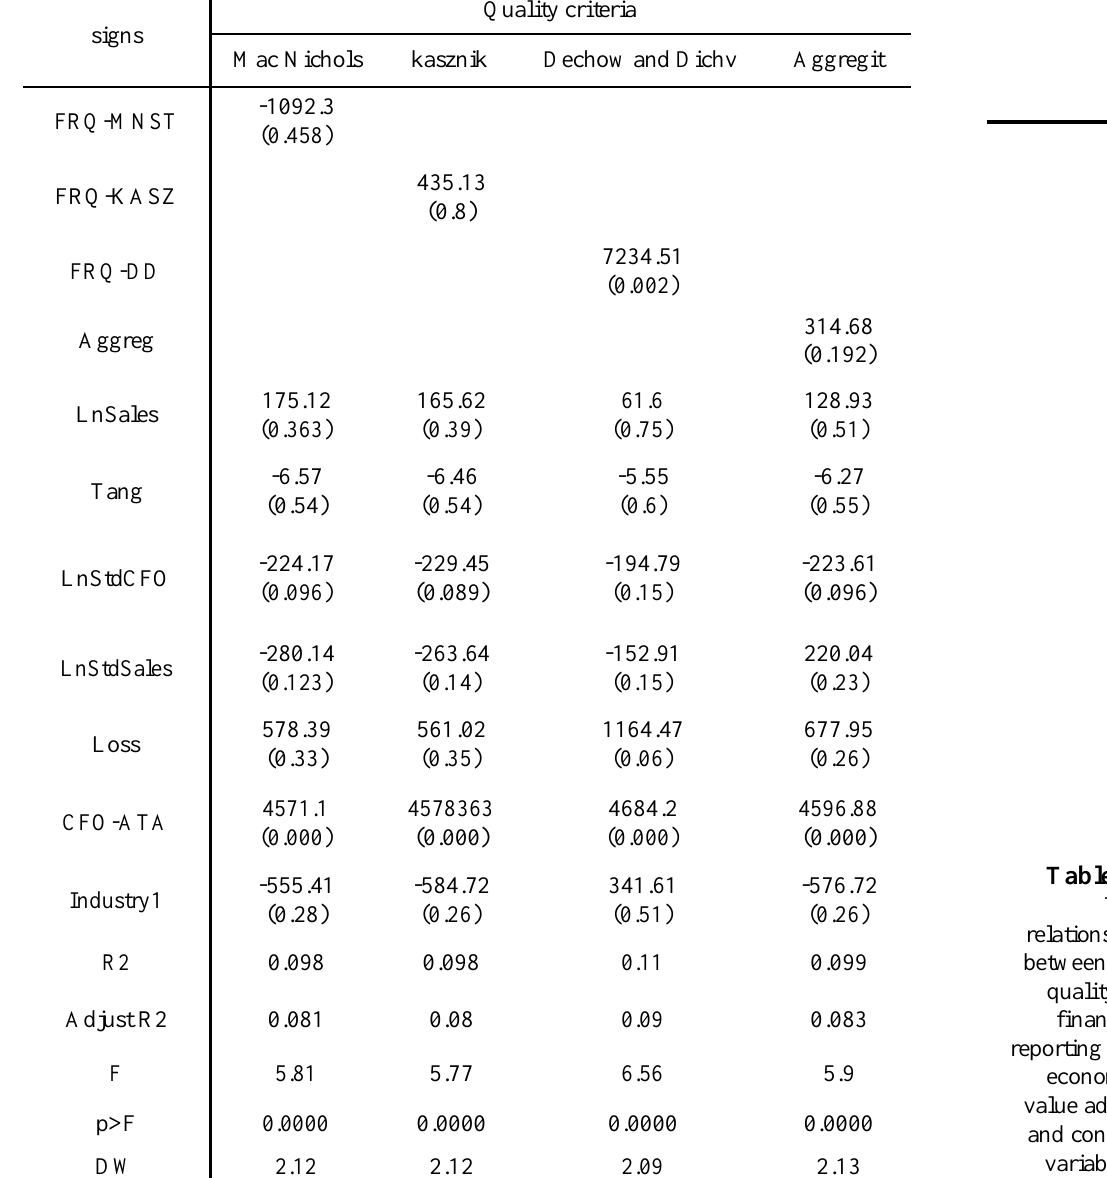
The relationship between the quality of financial reporting and economic value added and control